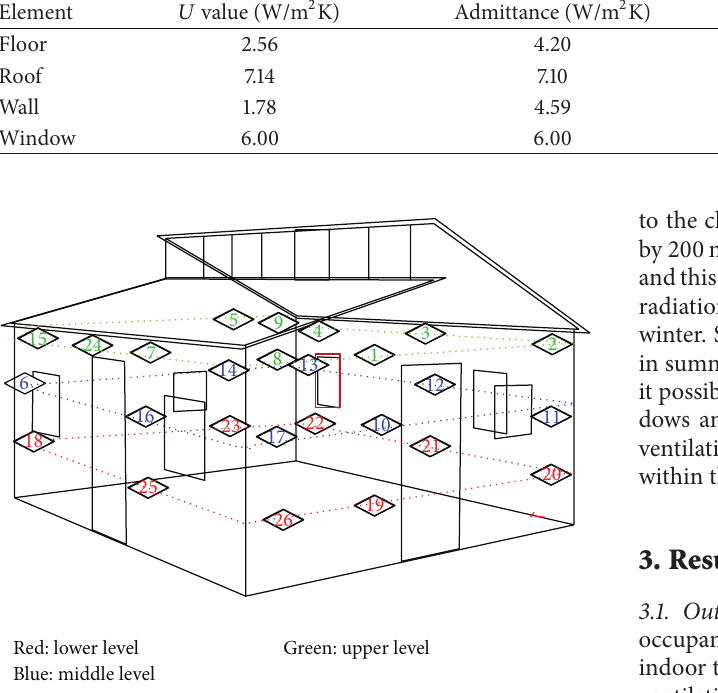
Figure 2: Distribution of